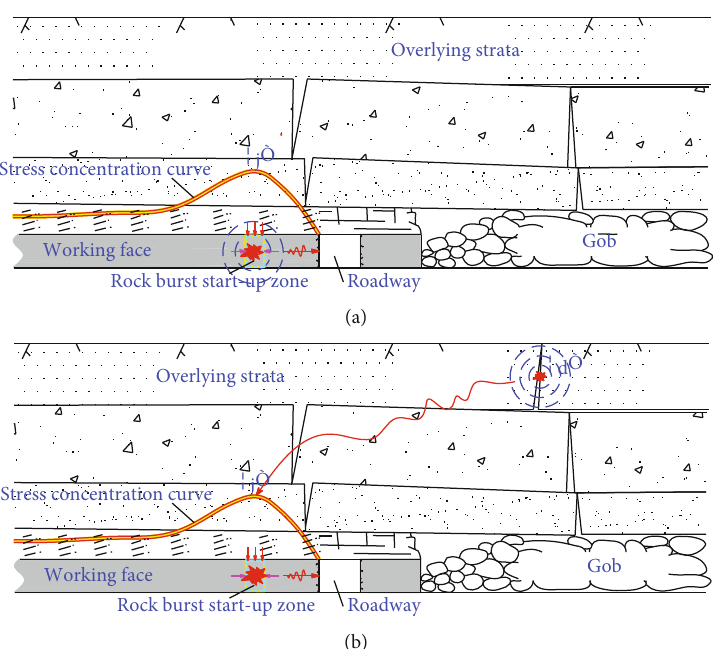
Figure 7: The occurrence mechanism schematic diagram of rock burst in roadway ribs. (a) Static load dominant type. (b) Dynamic load dominant